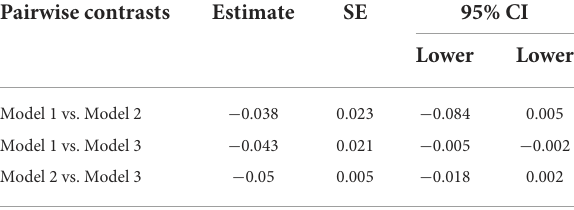
TABLE 5 The pairwise contrasts of the unstandardized indirect effects in the model of social support and death anxiety, mediated by presence of meaning and